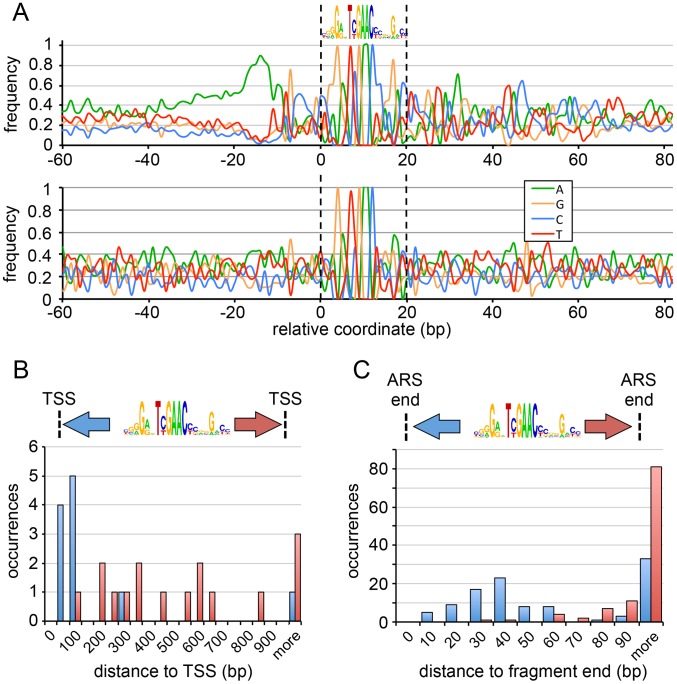
Sequence features of GC-ARSs.(A) Average nucleotide frequencies around 107 GC-ARS sites (top) and twenty-eight non-ARS intergenic occurrences of the GC-ACS (bottom), centered on the best match of the GC-ACS. The nucleotide frequencies are calculated at all flanking regions around the motif independent of whether the flanking region is present in ARS contigs or cores. (B) The distribution of distances between the GC-ACS motif (in the orientation shown) and the TSS for adjacent genes transcribing away from the ARS with available TSS annotations. Distances to the 5′ side of the motif are shown in blue; distances to the 3′ side of the motif are shown in red. (C) The distribution of sequence lengths between the GC-ACS and the end of the inferred functional core region for each GC-ARS. The 5′ distance is indicated in blue; the 3′ distance is indicated in red. Numbers indicate the upper limit of the bin.